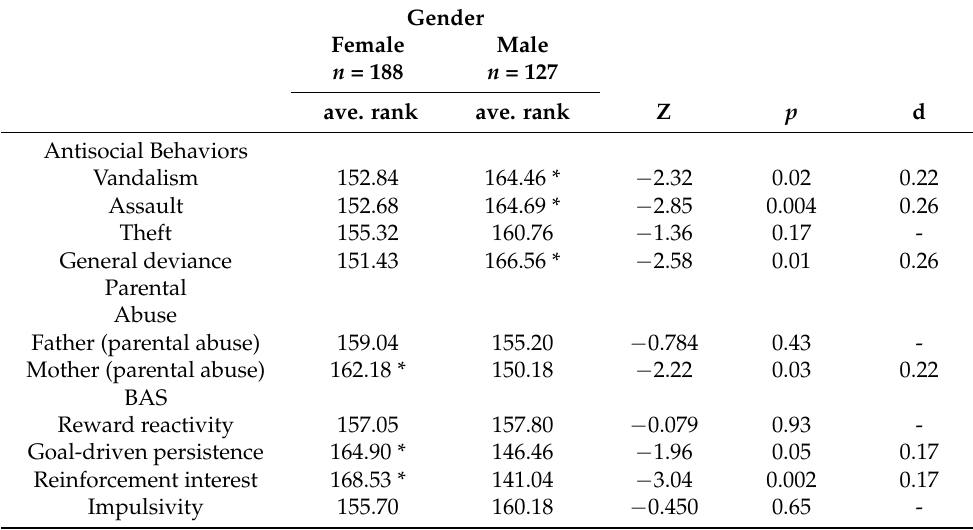
Table 3. Gender differences between variables.